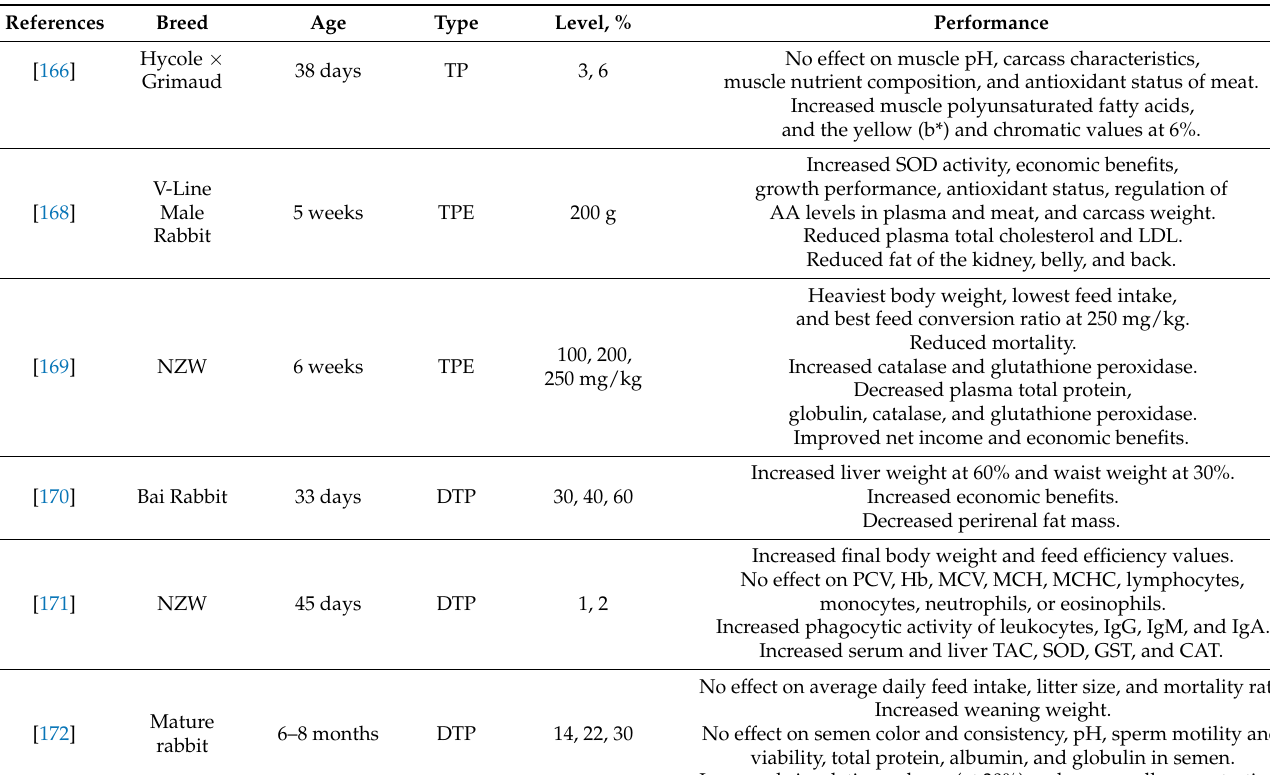
Table 9. The effect of tomato pomace on